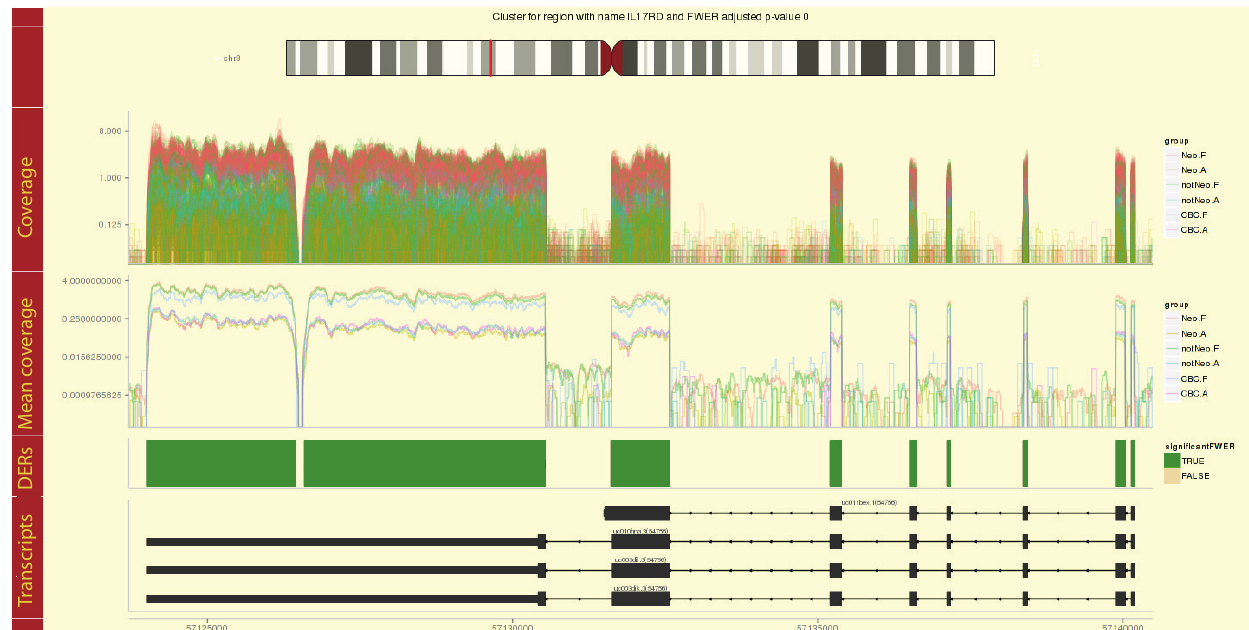
Figure 7. Example region cluster plot for the derfinder use case example with the BrainSpan dataset. Coverage curves are shown for each sample colored by their group membership. Mean coverage curves by group, differentially expressed regions (DERs) and known transcripts are shown in the remaining